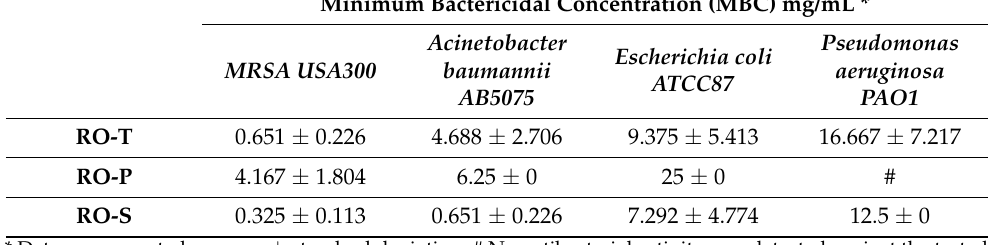
Table 1. Antibacterial activity of the tested